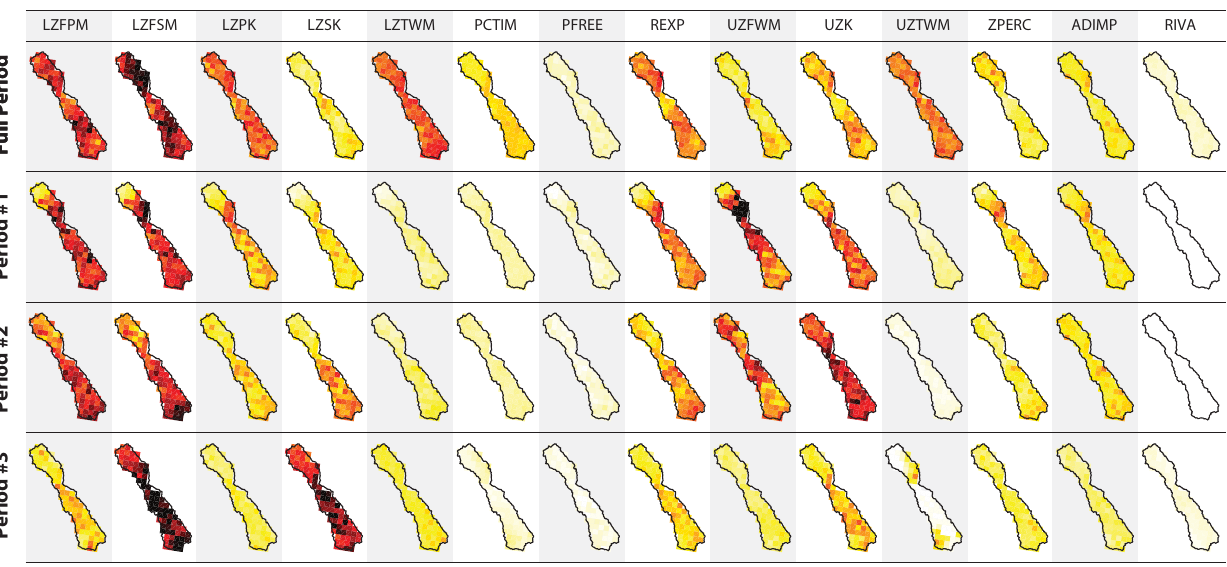
Fig. 5. Full period and event-scale sensitivities of the runoff coefficient error (ROCE) metric over the full six-month simulation and three selected sub-periods. The µ ∗ values from the method of Morris are scaled to the range [ 0 , 1 ] from an initial range of [ 0 , 0 . 08 ] . The ROCE metric focuses on the model’s ability to reproduce the observed long-term water balance. The spatial controls on the water balance are more evenly spread across the watershed compared to the RMSE metric in Figure 4.